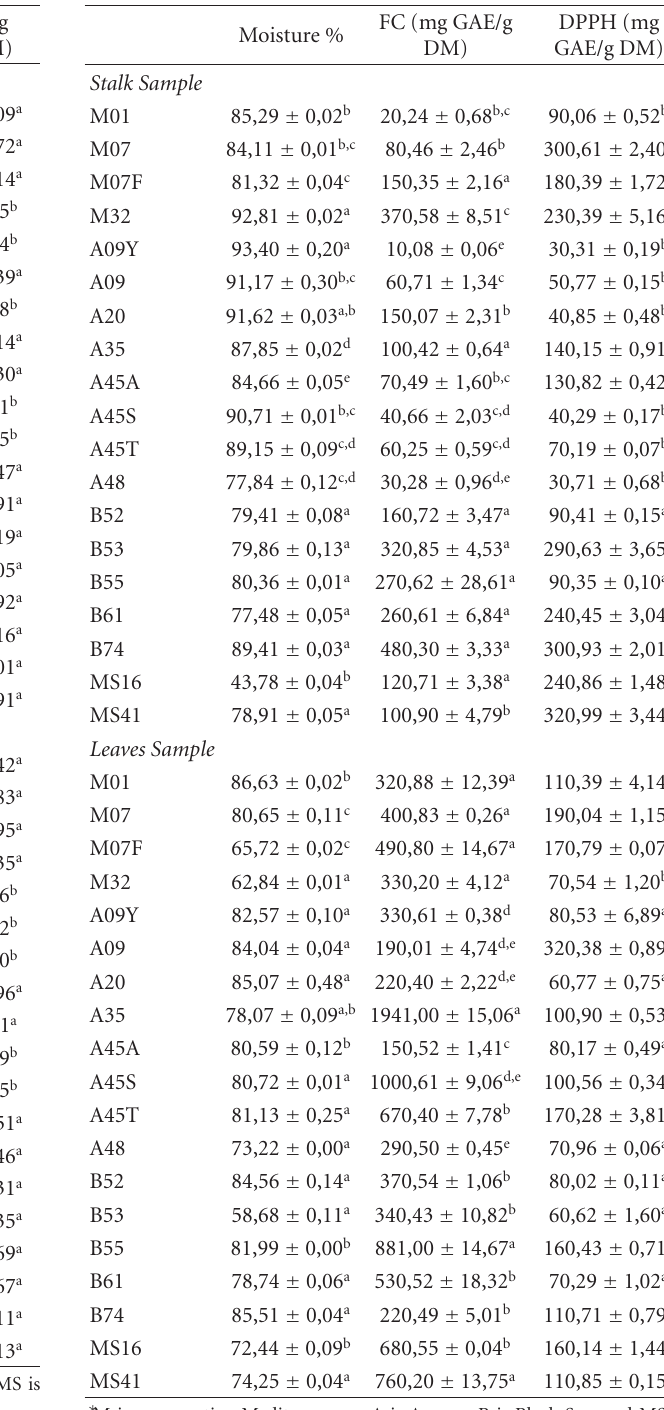
Table 2: Moisture content, total phenolic content, and total anti- oxidant activity of stalk and leaves of fresh